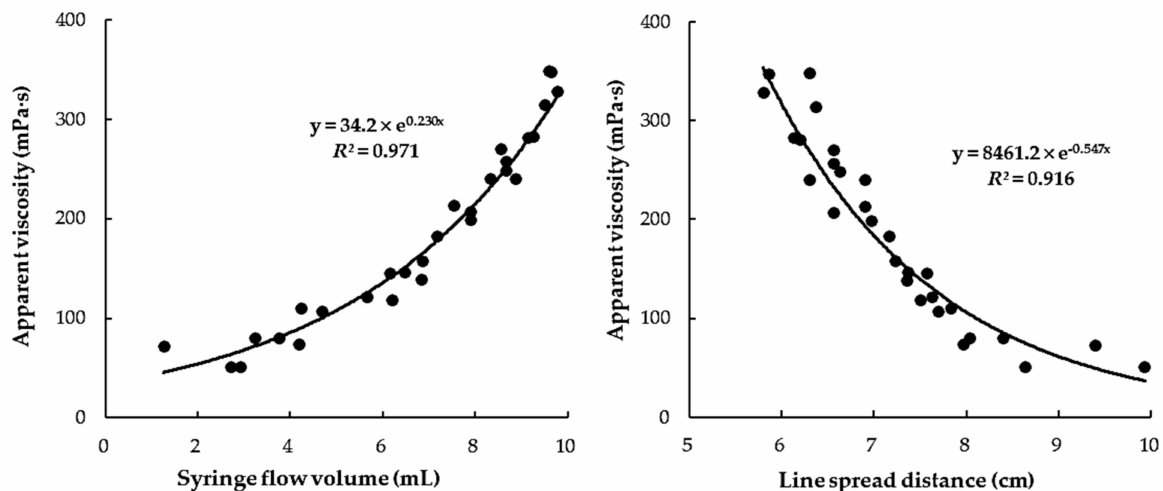
Figure 4. Correlation between apparent viscosity ( η a, 50 ) and flow volume (mL) by SFT or flow distance (cm) by LST values of fruit juice and sports drink-based thickened beverages in nectar-thick range (51–350 mPa ·